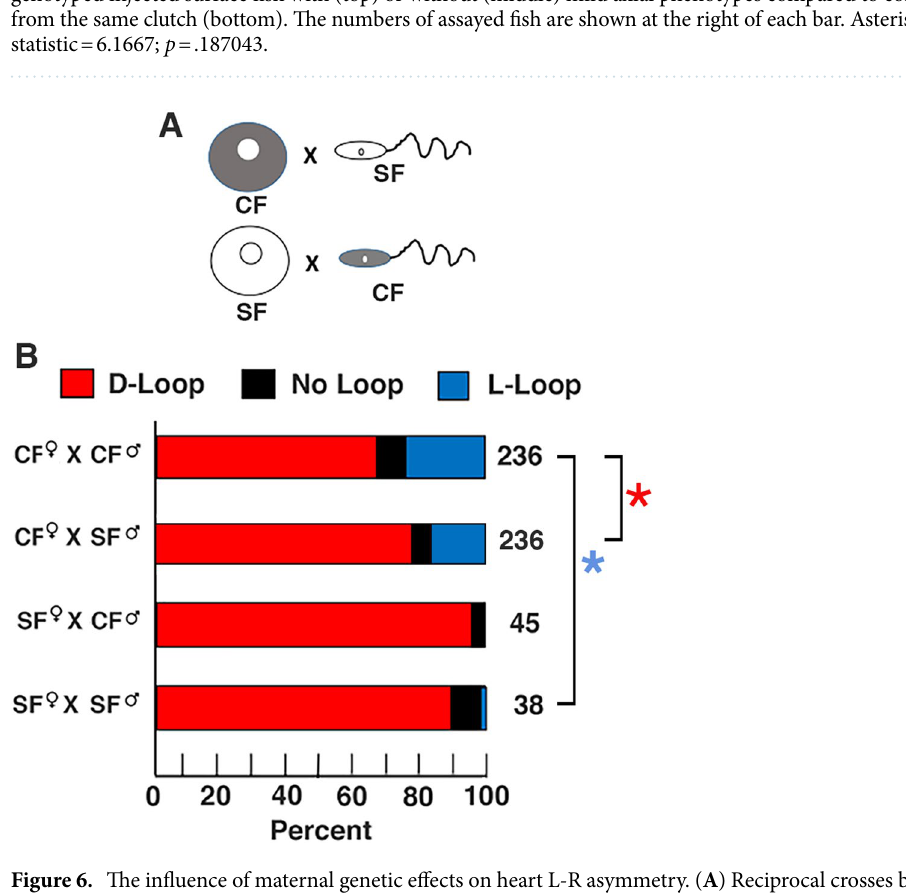
sp .; Sigma-Aldrich) for 15 s., then rinsed four times in fish system water, and incubated in 1 µM or 5 µM of each inhibitor for 8 h beginning at the shield-75% epiboly stage. Controls were treated for the same period in equiva- lent concentrations of DMSO. After inhibitor treatment, the embryos were rinsed four times with fish system water, cultured until 3 dpf, and then fixed and processed for MF-20 antibody staining as described above. RNA extraction and quantitative real time RT-PCR. Total RNA was extracted using TRI Reagent Solution (Life Technologies, Grand Island NY, USA), treated with RNase-free DNase (Qiagen, Frederick, MD) to remove traces of genomic DNA, and cDNA was synthesized using the SuperScriptTM III First-Strand Synthesis